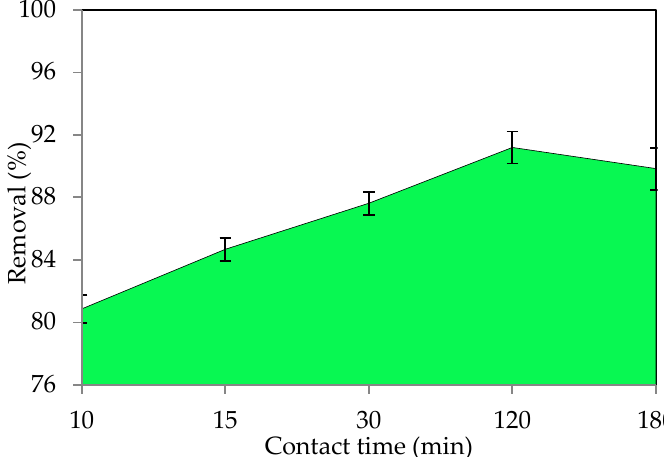
Figure 6. Effect of contact time on the removal of IV2R by ZnO ‐ NPs.